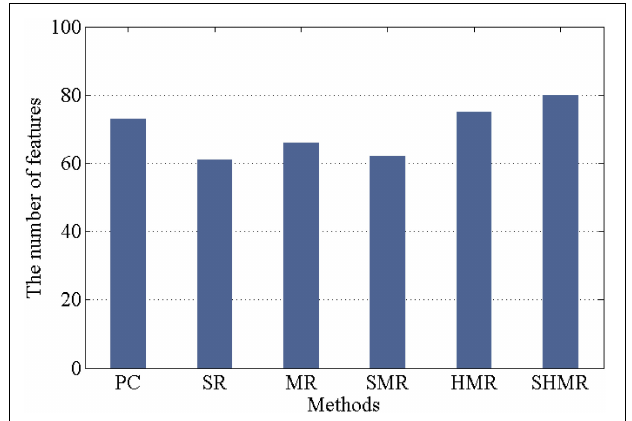
FIGURE 4 | Number of features selected by different methods in 10-fold